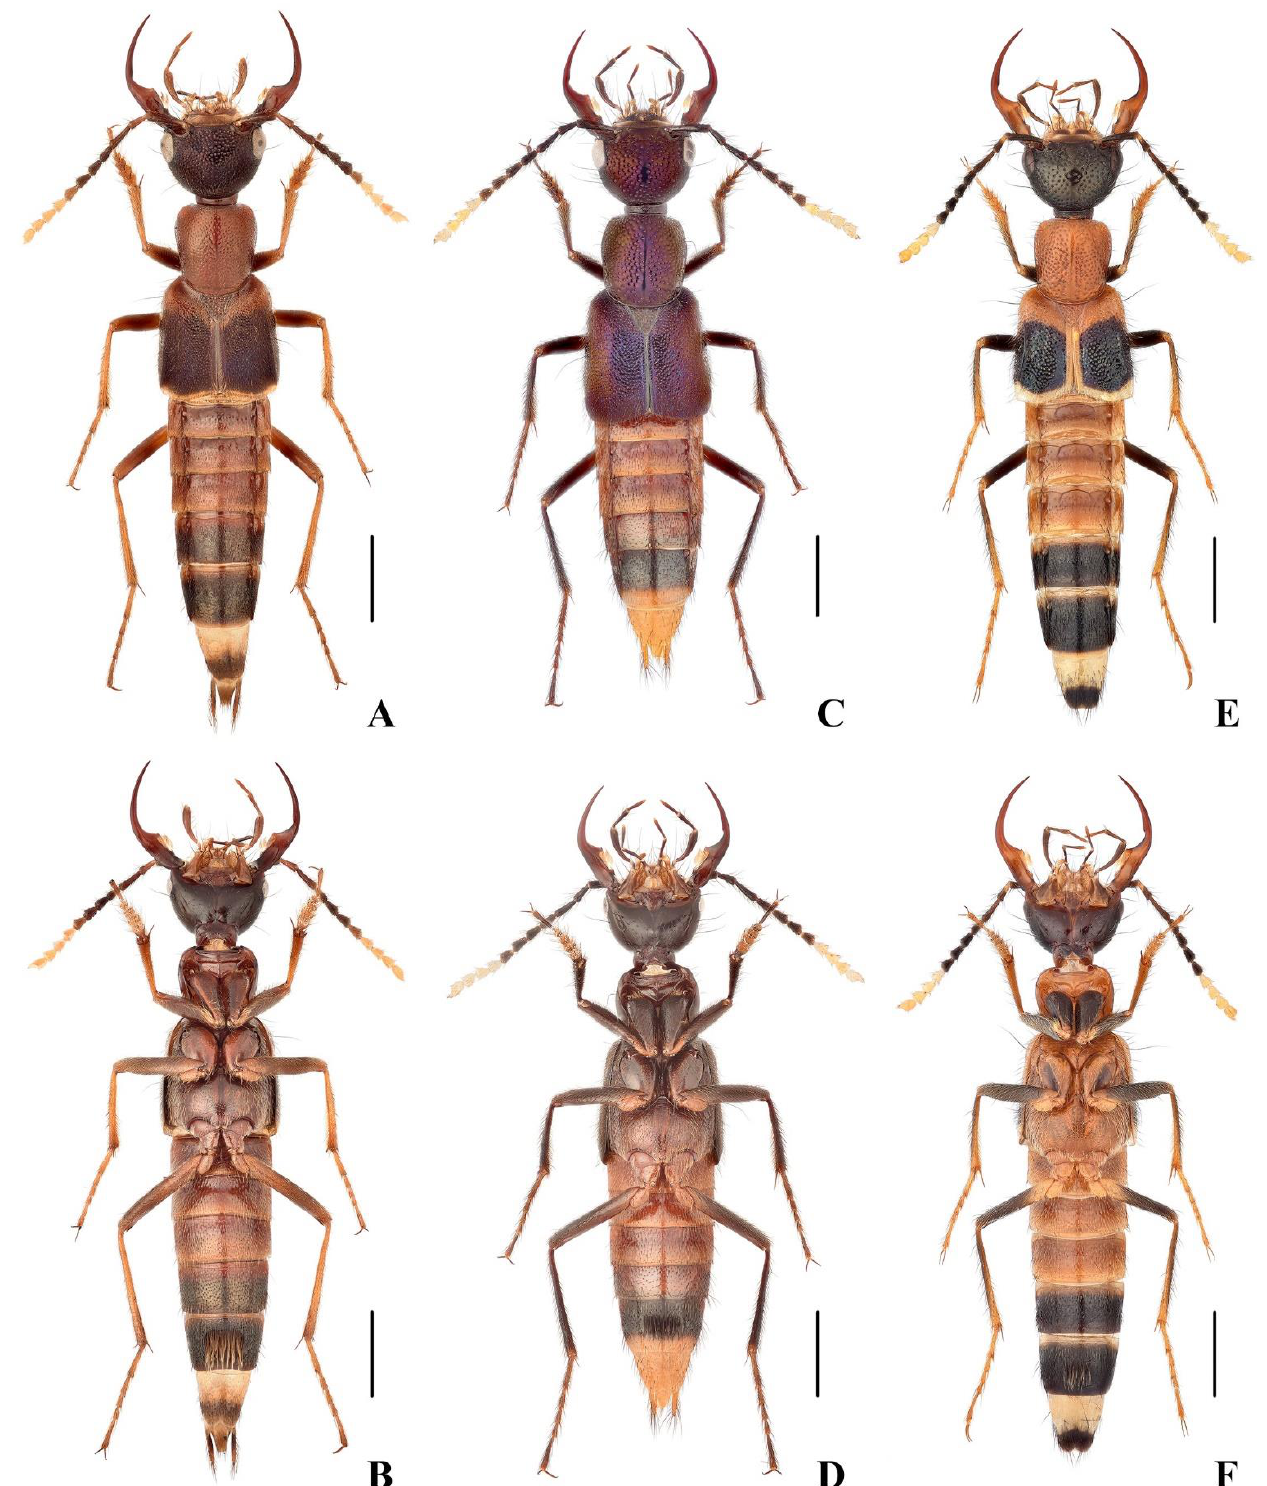
Figure 1. ( A – F ). Adult habitus of Hesperoschema . ( A , B ) H. xuwangi ; ( C , D ) H. malaisei ; ( E , F ) H. bii . Scale bars = 2 mm.